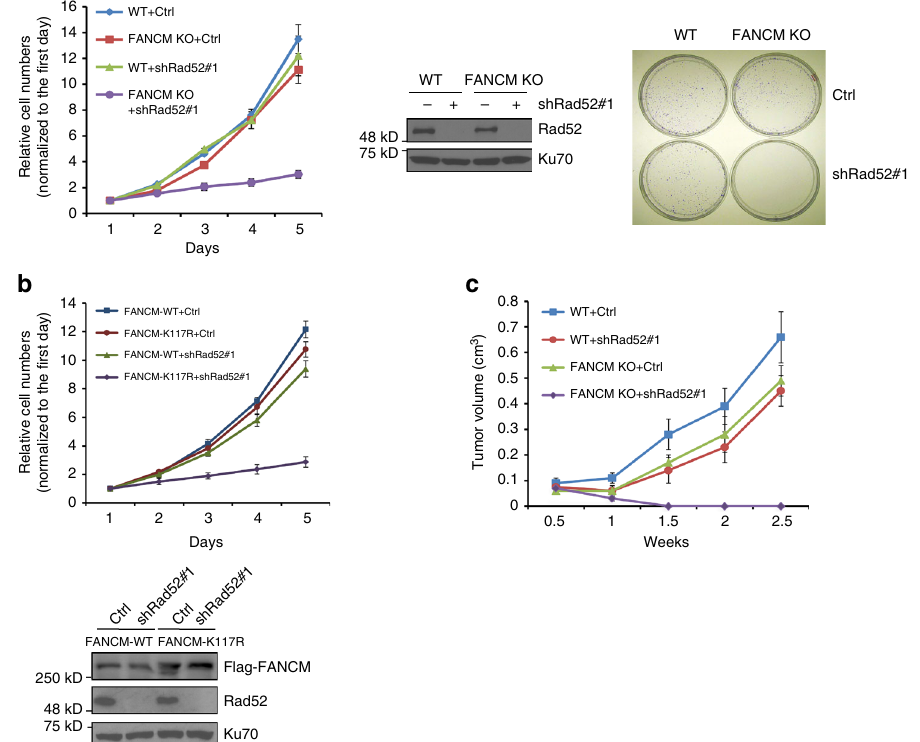
Fig. 6 Inactivation of Rad52 drastically reduces the growth of FANCM KO cells and tumors. a , b Growth curve of HCT116 WT or FANCM KO cells was plotted after expressing Rad52 shRNA or control vector ( a , left), or FANCM KO cells expressing FANCM WT or K117R followed by expression of Rad52 shRNA or control vector ( b ). The viability of HCT116 WT or FANCM KO cells expressing Rad52 shRNA or vector was analyzed by colony formation assay ( a , right). c Tumor volume was measured in nude mice after tumor inoculation with HCT116 WT or FANCM KO cells expressing Rad52 shRNA or vector. Data are shown as the mean ± SD of tumor volumes of fi ve mice in each group at each time